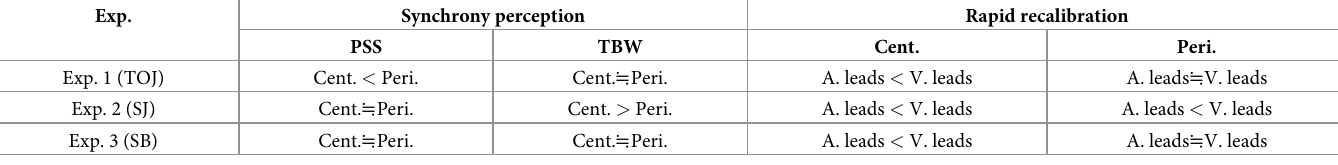
Table 1. Summary of the three experiments’ main findings.